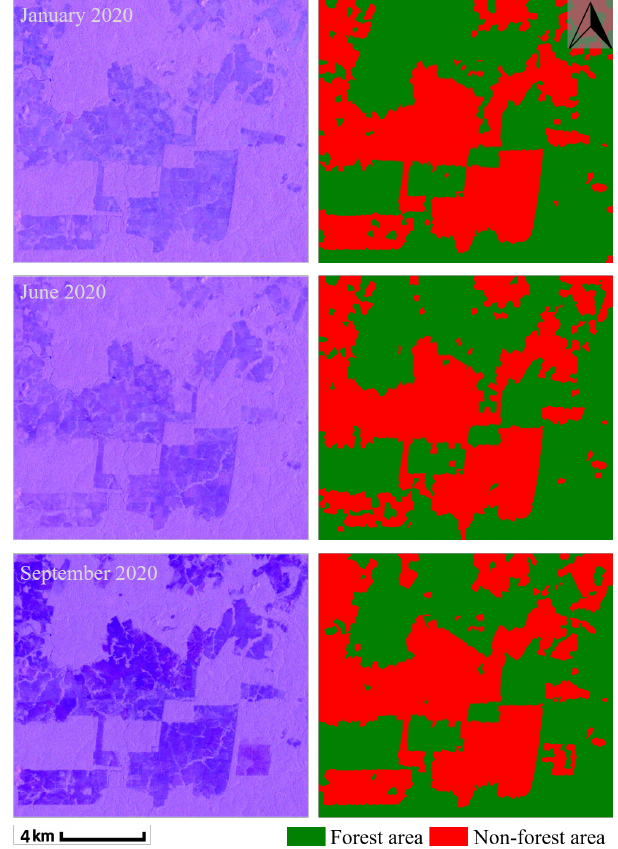
Figure 7. Some examples from the Timeframe 2 processing. On